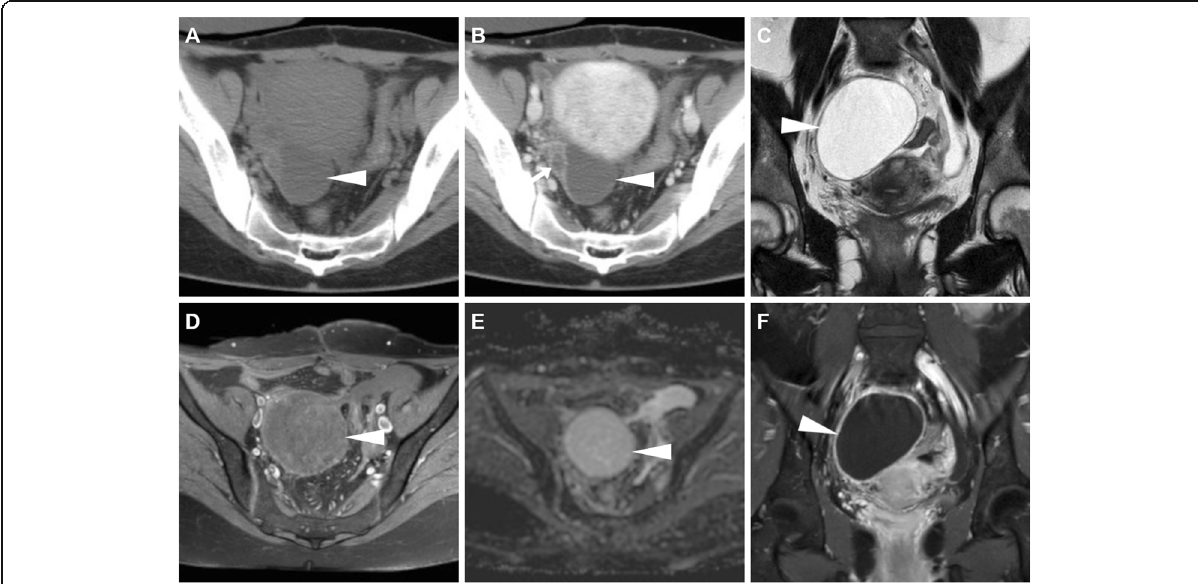
Fig. 4 A surgically proven, progressively enlarging ovarian cyst. Initial unenhanced ( a ) and post-contrast ( b ) CT images depicted a 4 × 3 cm non- enhancing retrouterine cystic lesion (arrowheads) demarcated by a thin regular wall. Weeks later, MRI showed cyst enlargement with homogeneous T2-weighted fluid signal ( c ), without evidence of blood on precontrast fat-suppressed T1-weighted sequence ( d ), with unrestricted